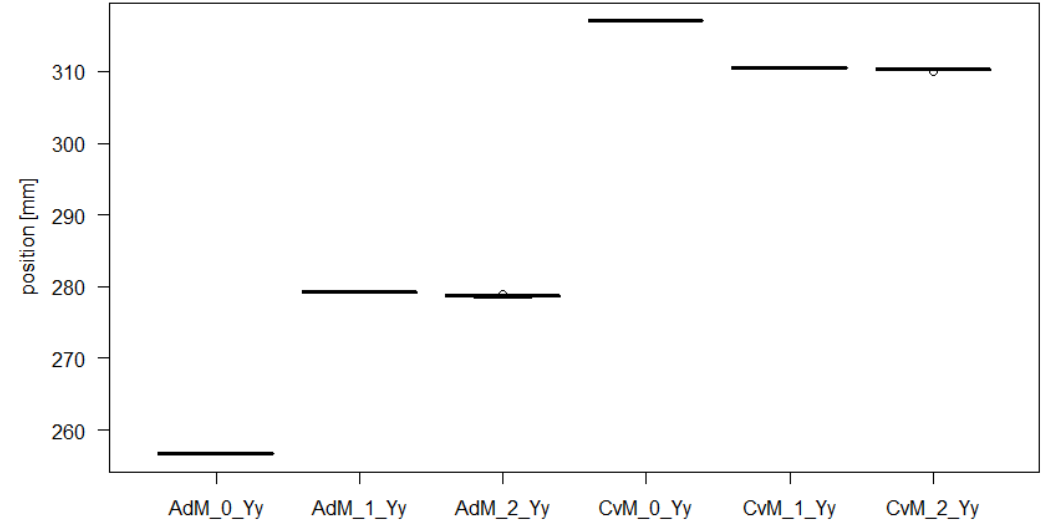
Figure 14. Measurements of CoM axis Y.